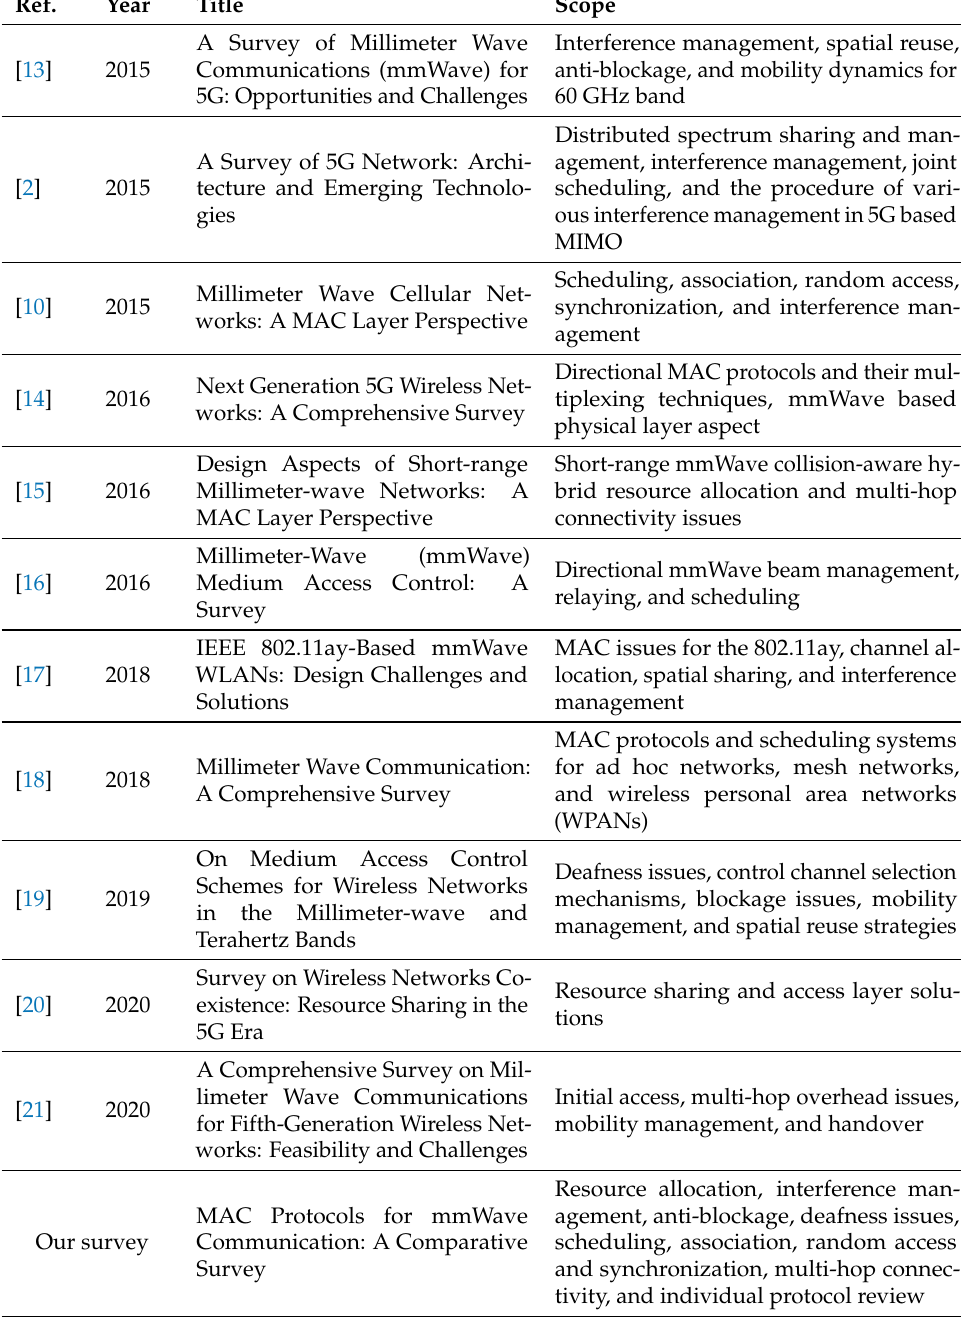
Table 1. Comparative analysis of the existing surveys.